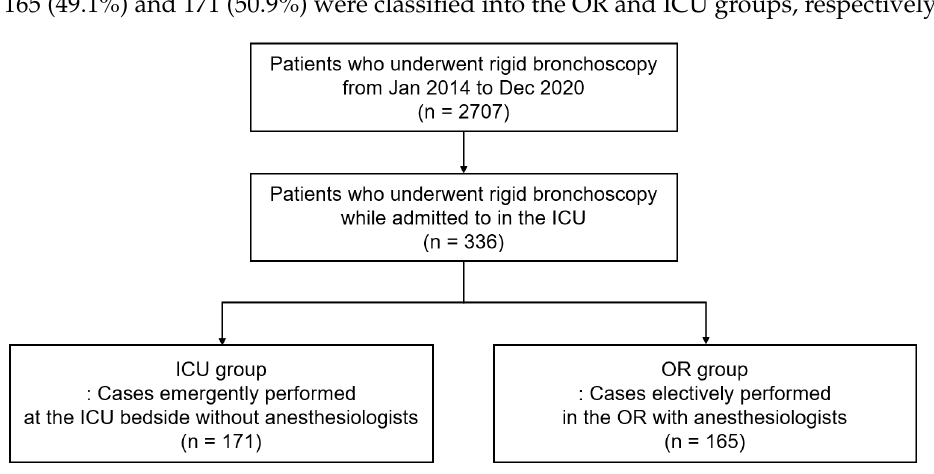
Figure 1. Flow chart of the study. ICU = intensive care unit, OR = operating room.